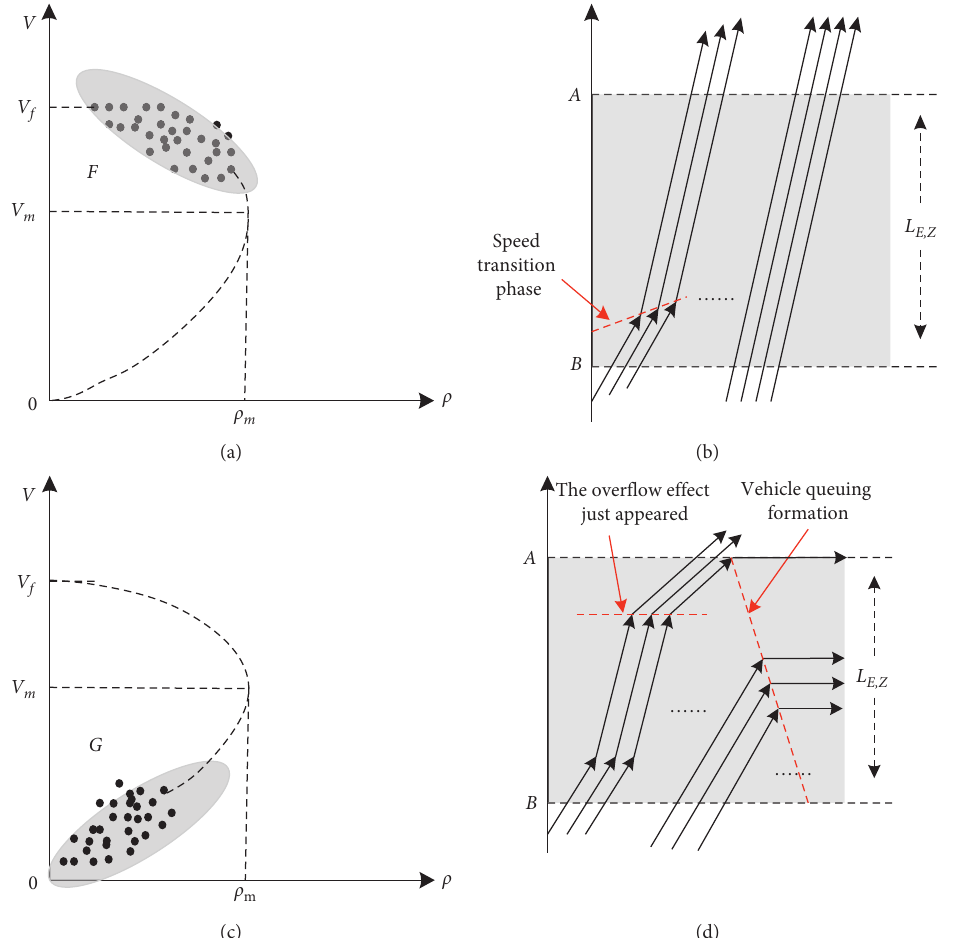
Figure 5: Effective detection of changes in traffic flow characteristics. (a) Fundamental diagram of normal traffic flow. (b) Normal traffic shock wave. (c) Fundamental diagram of traffic overflow. (d) Overflow traffic shock wave.